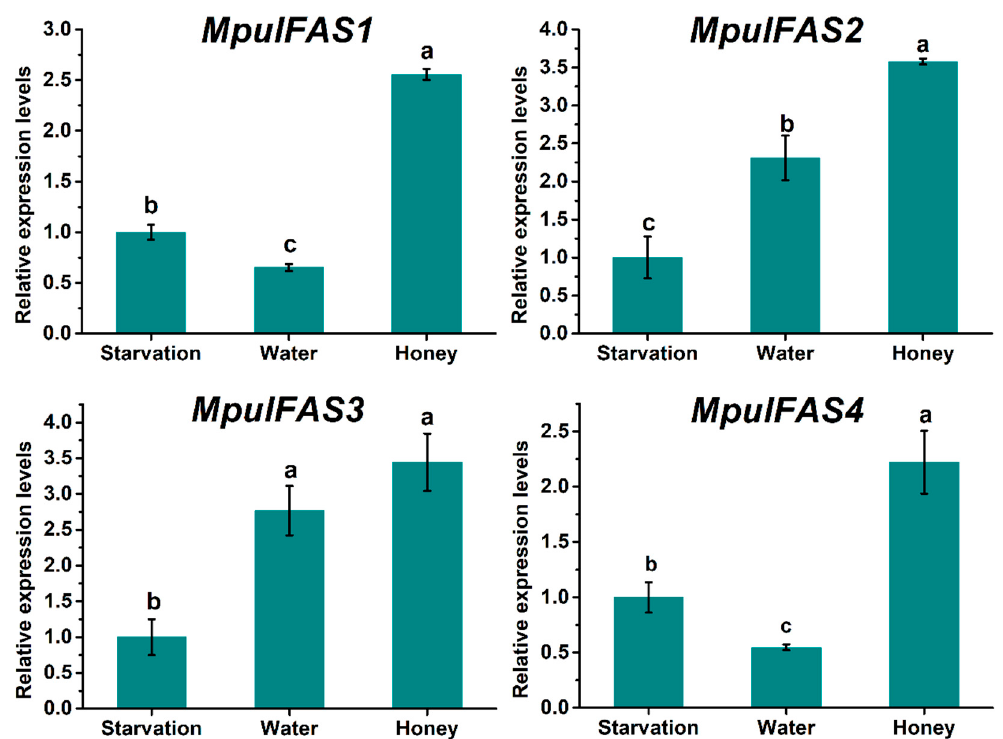
Figure 3. Expression of MpulFASs at different feeding treatments in three-day-old adult wasps. The relative expression level was calculated using the 2 −ΔΔ Ct method. A one-way analysis of variance (ANOVA) with Tukey’s post-hoc test was used to check for significant differences in the expression levels of each target gene among the treatments. The different lowercase letters above the bars indicate groups with significant differences ( p < 0.05).